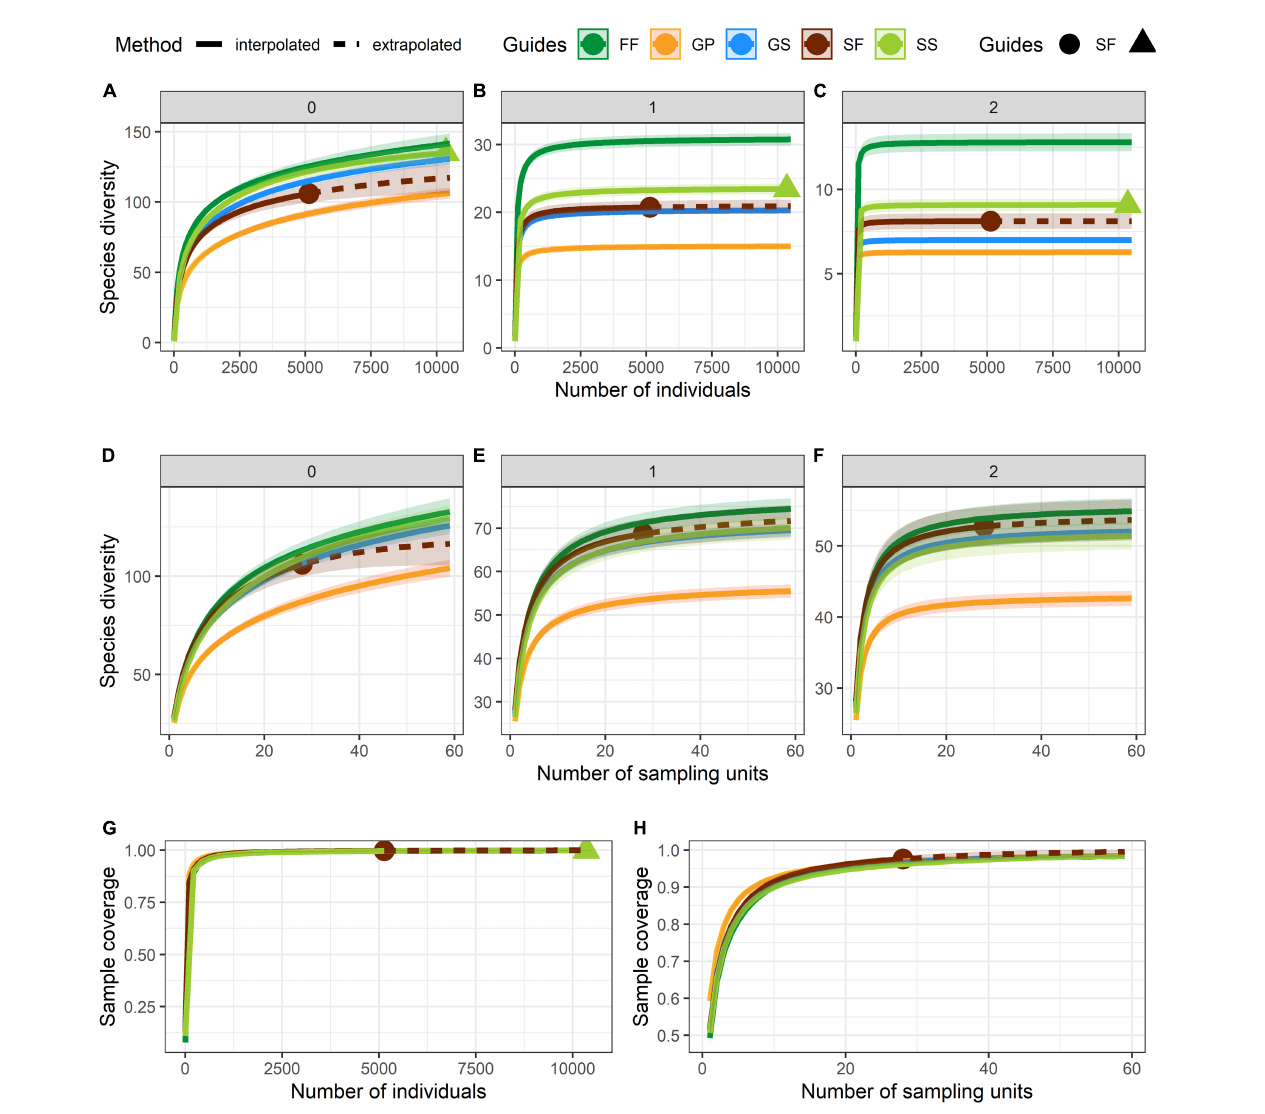
FIGURE6 Curves of Hill’s numbers for each vegetation transition types (VTTs). (A–C) Abundance-based Hill’s numbers. (D–F) Incidence-based Hill’s numbers. In panels (A) and (D) : q = 0 (species richness); in panels (B) and (E) : q = 1 (exponential of Shannon’s entropy index); in panels (C) and (F) : q = 2 (inverse of Simpson’s concentration index). (G) Sample completeness (sample-coverage) curve for abundance data. (H) Sample completeness (sample-coverage) curve for incidence data. 95% confidence intervals (CIs) were indicated by the shade areas above and below each curve and were obtained